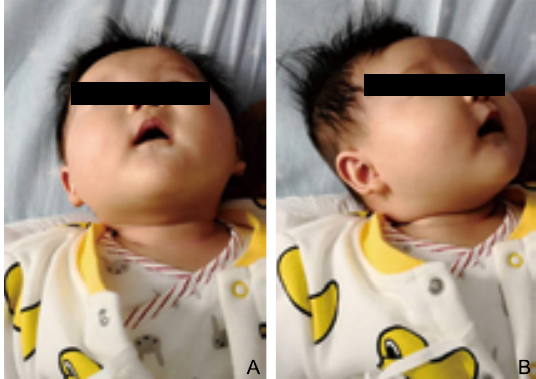
Figure 1 A 8-month-old boy with the neck symmetrically supine (A) and extended to left to maximum angle (B). The examination area was fully exposed, and the probe was transversely (A) and longitudinally (B) scanned along the SCM muscle. In Figure 2, in the sonoelstrogram (F), the histogram indicates the stiffness of the ROI of SCM muscle; the transverse (G) and longitudinal (H) view of SCM muscle in strain elastography, measuring the strain ratio of SCM muscle (I) and displaying the histogram (J). In the sonoelastogram (G, H), the colors ranging from red (hard) to blue (soft) represent the relative stiffness of the tissue. In sonoelastogram (I), the upper circle (strain 1) indicates ROI of the subcutaneous tissue (reference tissue), and lower circle (strain 2) is ROI of SCM muscle. In the sonoelastogram (J), the left histogram indicates the stiffness of ROI of the subcutaneous tissue, and the right histogram indicates the stiffness